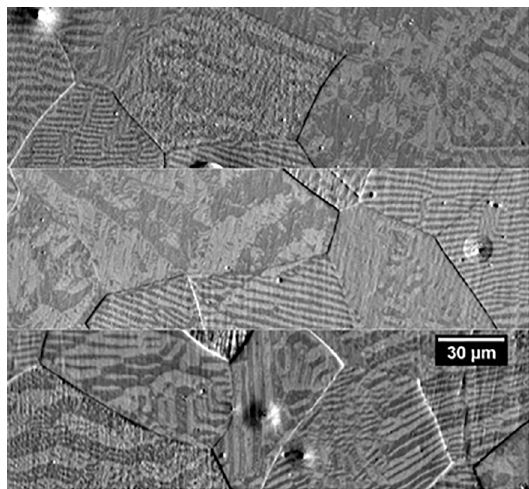
Figure 9. Changes on magnetic domain morphology caused by grain boundaries and texture, S79 before aging.